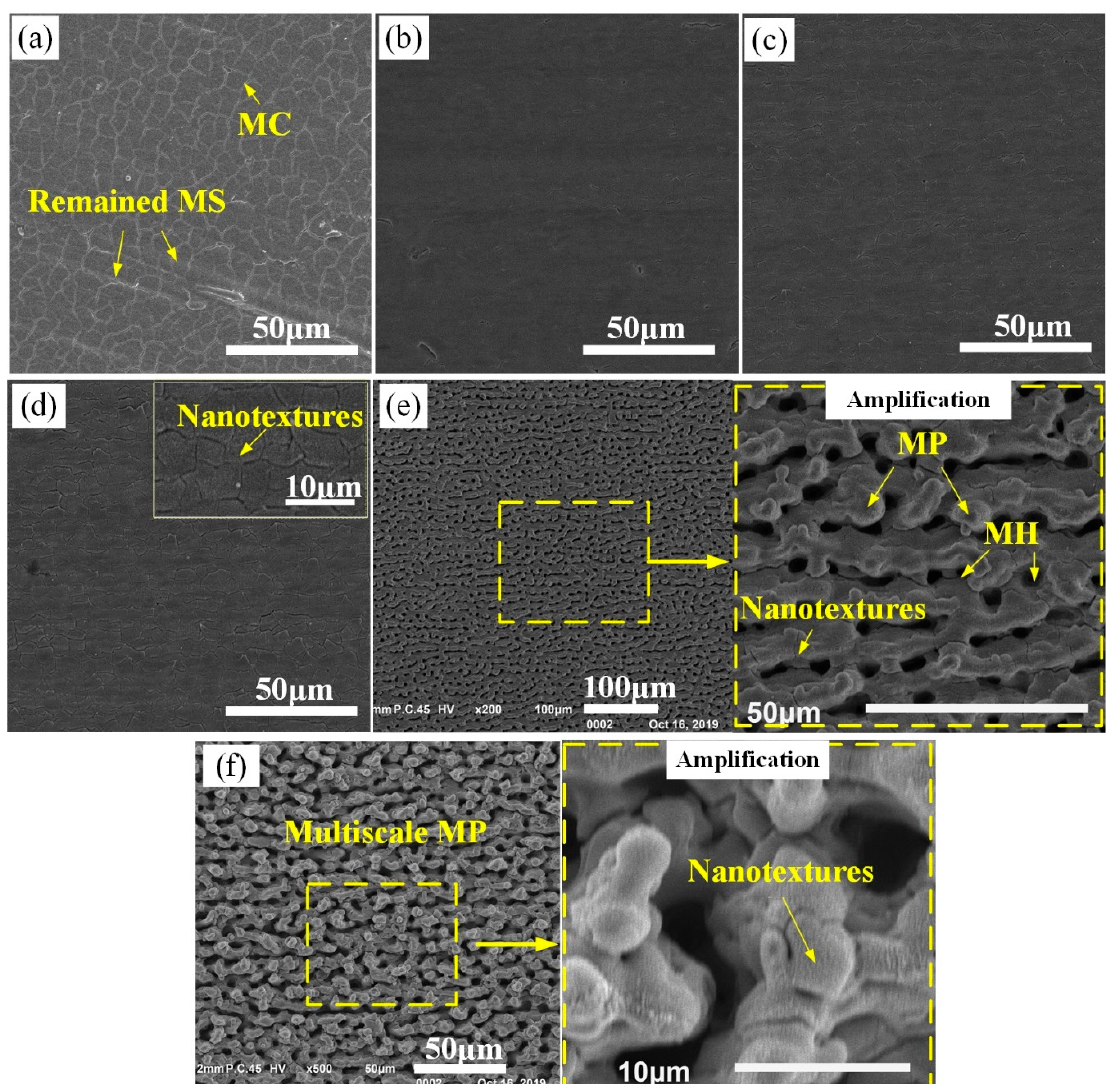
Figure 3. Morphology of first-step laser-irradiated surfaces at various F p1. ( a ) 1.1 J/cm 2 ; ( b ) 1.9 J/cm 2 ; ( c ) 2.4 J/cm 2 ; ( d ) 2.9 J/cm 2 ; ( e ) 3.4 J/cm 2 ; ( f ) 4.0 J/cm 2 .